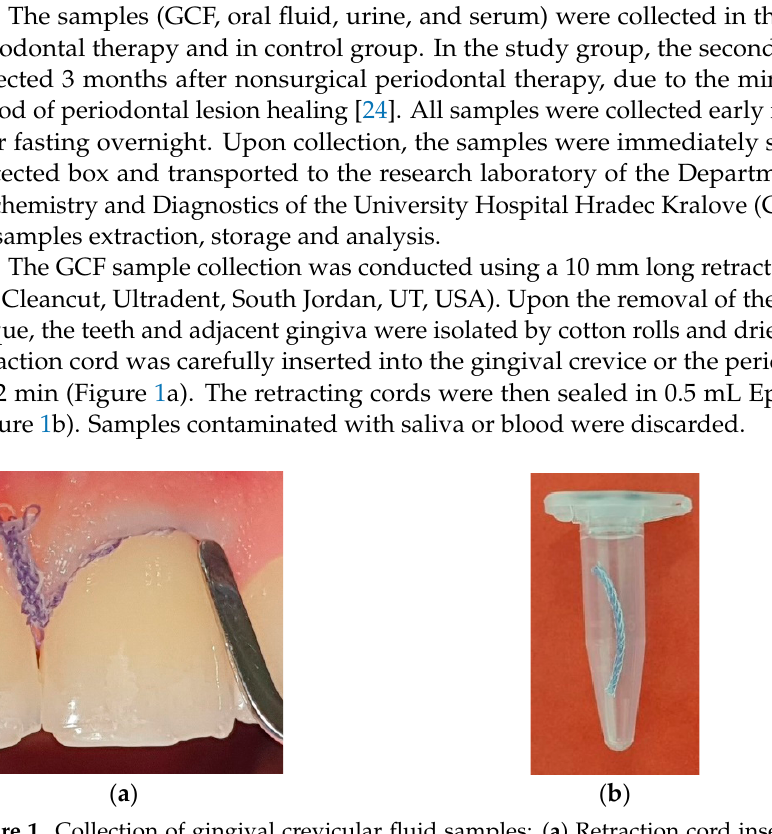
Figure 1. Collection of gingival crevicular fluid samples: ( a ) Retraction cord inserted to gingival crevice and periodontal pocket, respectively; ( b ) Retraction cord sealed in Eppendorf tube.